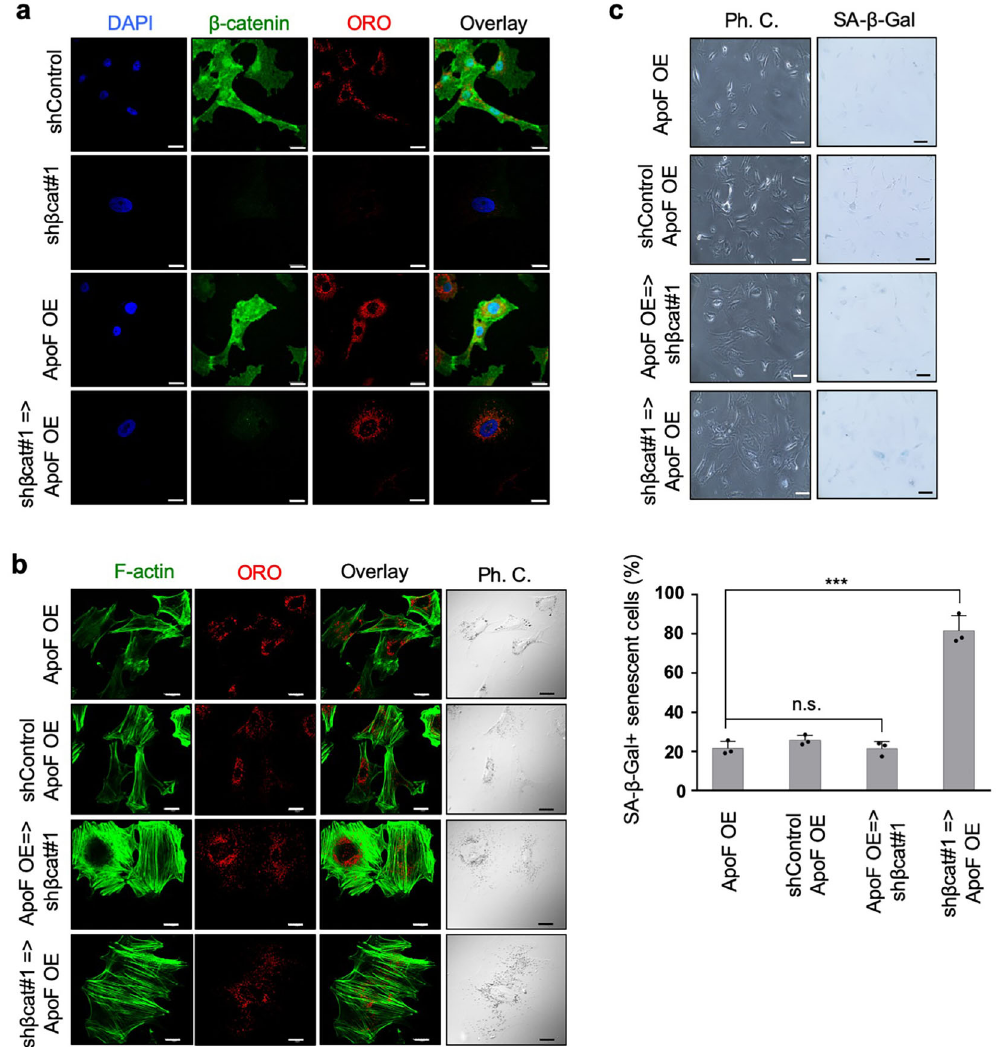
Fig. 7 ApoF restores lipid droplets under conditions of β -catenin depletion. a Immuno fl uorescence images demonstrating lipid droplet restoration by ApoF overexpression. Scale bars, 20 μ m. b Immuno fl uorescence images demonstrating changes in cell size and actin rearrangement upon β -catenin knockdown and/or ApoF overexpression. Scale bars, 20 μ m. c SA- β -gal assay of NSFs expressing the indicated shRNA and/or ApoF cDNA (left). Scale bars, 100 μ m. Quantitative results showing the percentage coverage of senescent cells versus that by total cells in the SA- β -gal assay (right). Data are expressed as the mean ± standard deviation ( n = 3 biological replicates). *** P < 0.001 and n.s., not signi fi cant; two-sided Student ’ s